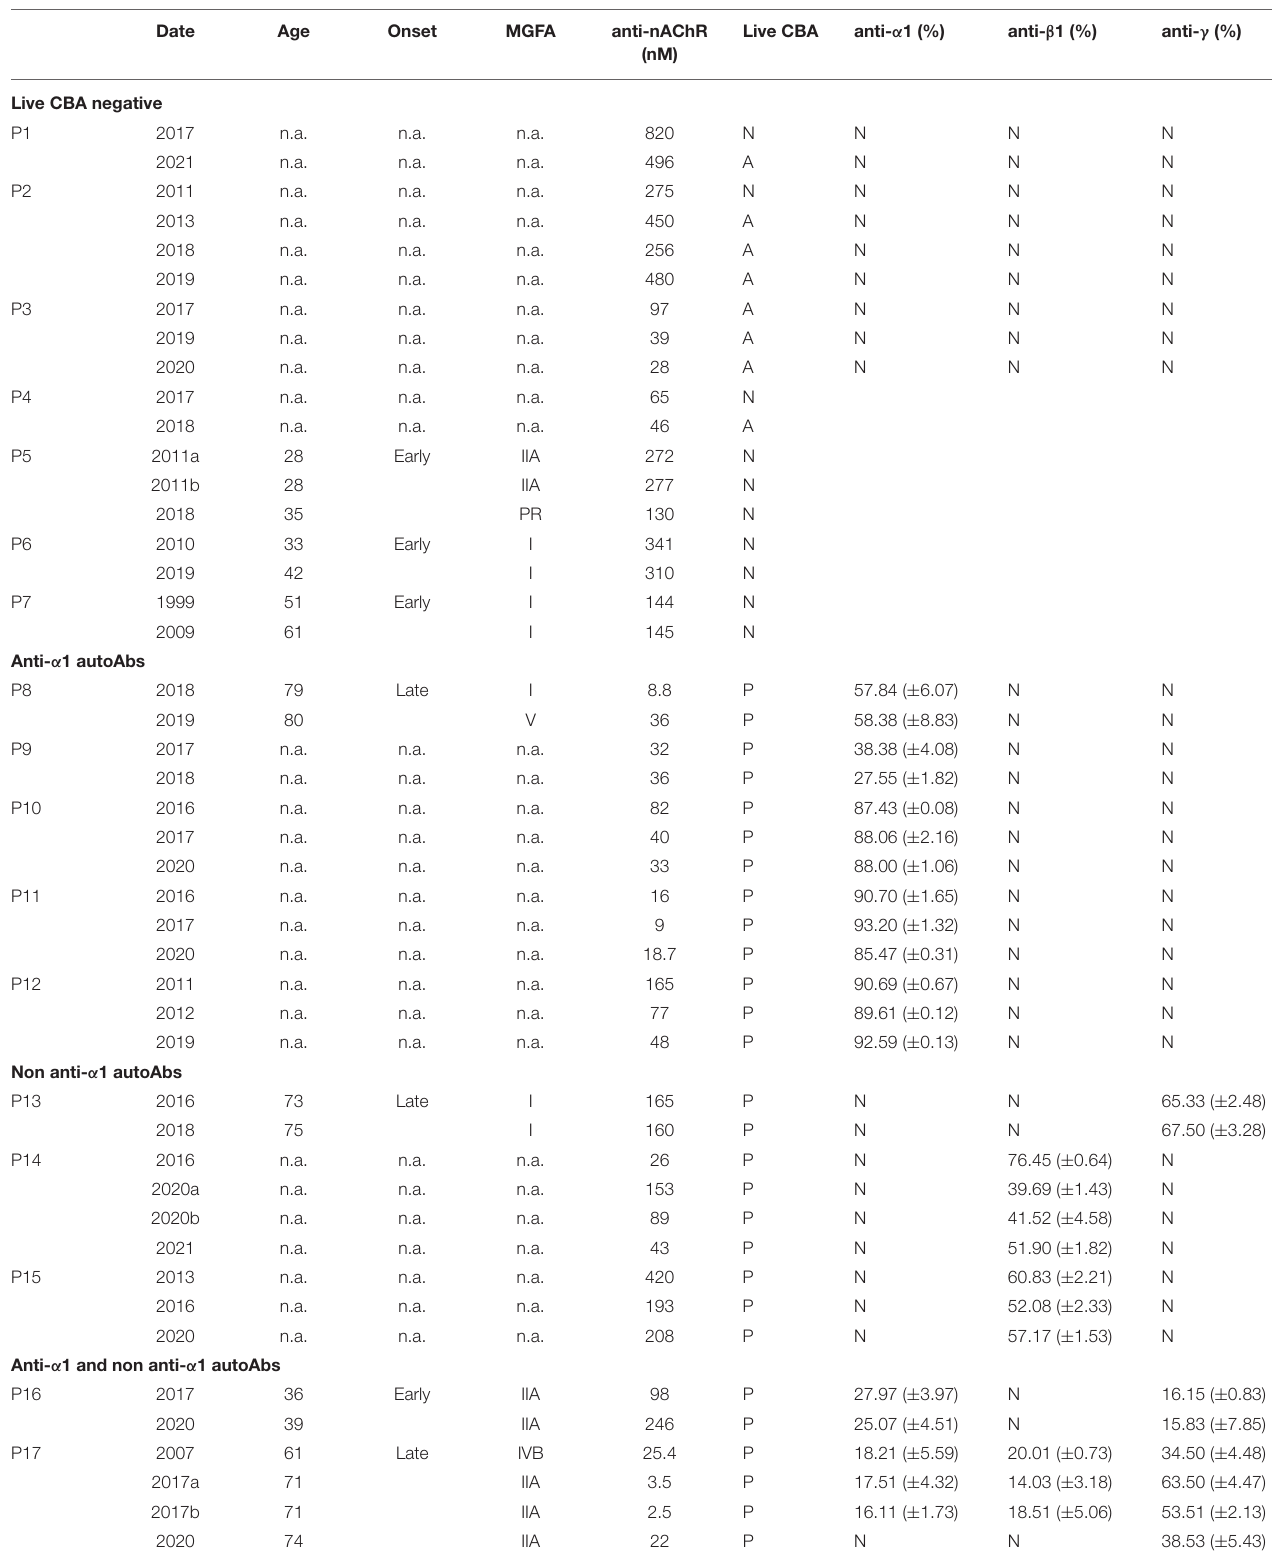
TABLE 1 | Results of the tested